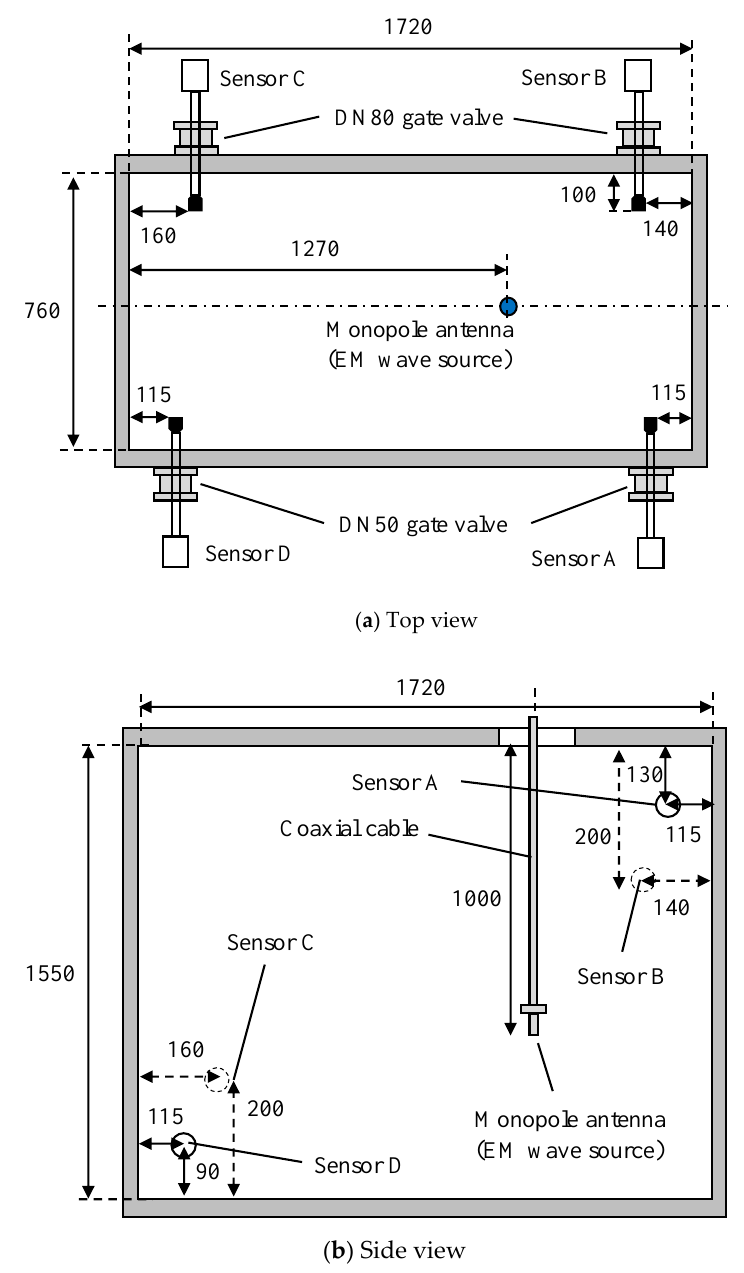
Figure 1. Schematic diagram of a transformer tank and antenna positions (for the first experiment).